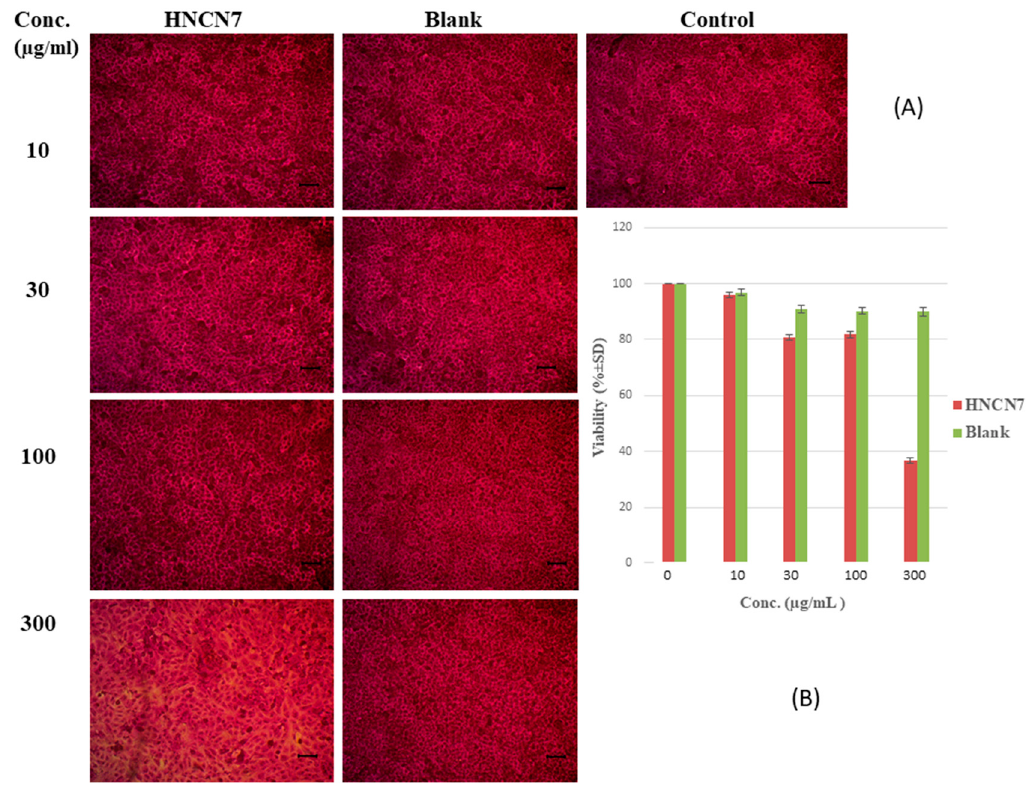
Figure 5. ( A ) Optical microscopy images of cells growth in presence of different concentrations of HNCN7 and the unmedicated HNCN7 (blank) by SRB assay and ( B ) Cell viability of human skin fibroblast cultured in presence of different concentrations of HNCN7 and the unmedicated HNCN7 (blank) (scale bar = 1 μ m).